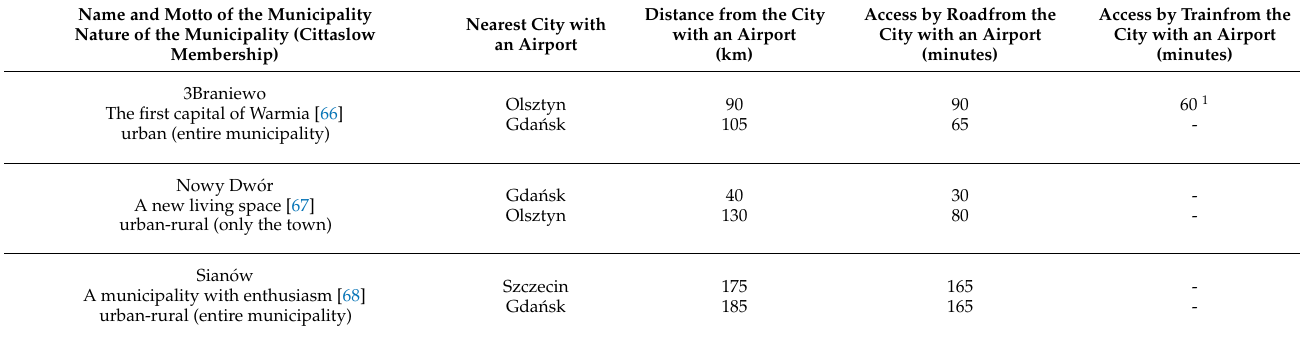
Table 2. Basic information on and access by road and train to Polish coastal Cittaslow towns. Name and Motto of the Municipality Nature of the Municipality (Cittaslow